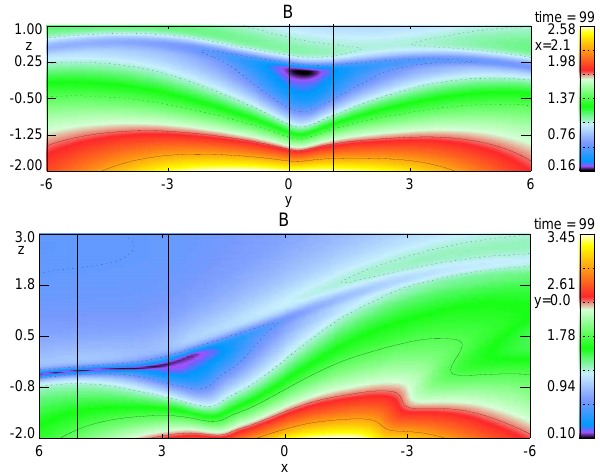
Fig. 15. Total magnetic field ( | B | ) in the y-z plane (top), and x- z plane (bottom) for southward IMF. The CDC region is indicated by low magnetic field magnitude. The boundary normals used to address the geometry of the outer boundary are computed approxi- mately along the vertical lines in the figures.